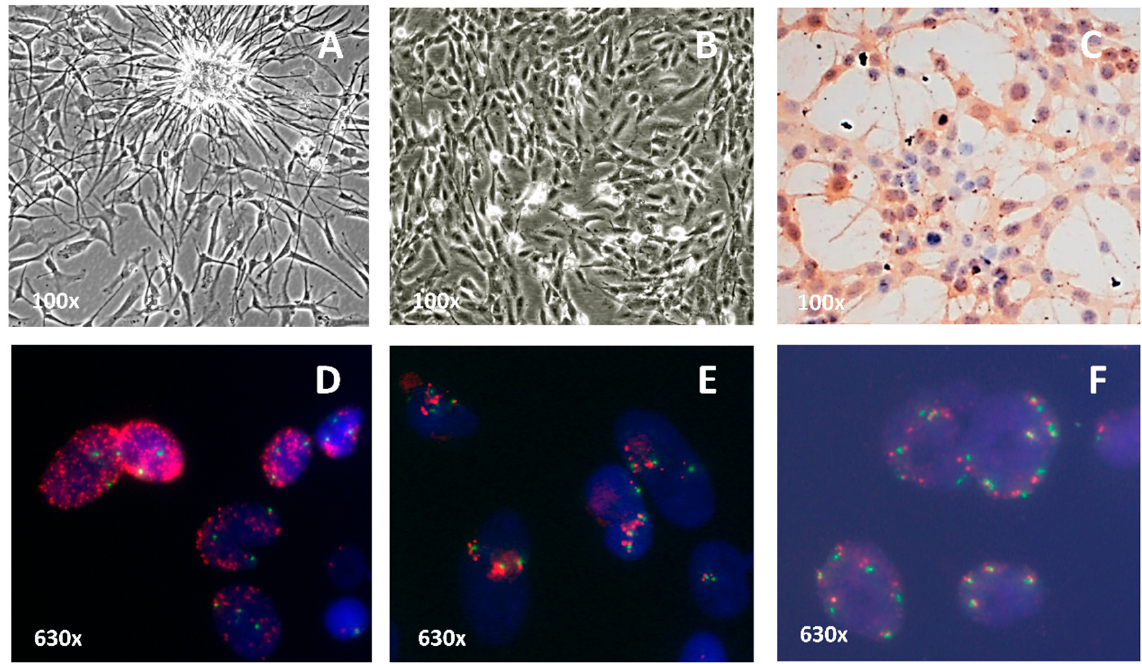
Figure 2. Characterization of the short-term cell cultures. ( A ) Cells with an elongated morphology and cytoplasmic expansions in HC-466 culture (100x). ( B ) Cells with a variable morphology and many mitoses in HC-534 culture (100x). ( C ) Positive expression of the GFAP protein in HC-444 culture (100x). ( D ) Tumor cells with a high level of EGFR amplification in HC-466 culture (630x). ( E ) Tumor cells with low level of EGFR amplification in HC-534 culture (630x). ( F ) Cells without EGFR amplification in HC-444 culture (630x). FISH analysis was carried out with the dual probe for EGFR (red) and centromere of chromosome 7 (green). The FISH micrographs are representative from three independent experiments.